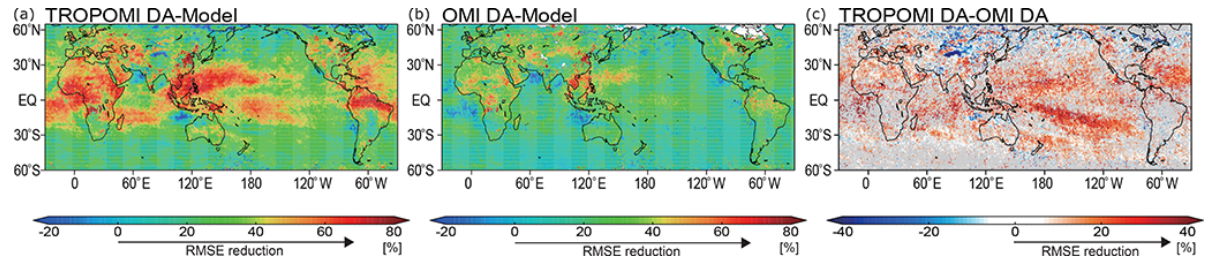
Figure 2. Root-mean-square error (RMSE) reduction for tropospheric NO 2 concentration fields against assimilated observations by data assimilation (DA) (%) obtained from Tropospheric Monitoring Instrument (TROPOMI) DA (a) and Ozone Monitoring Instrument (OMI) DA (b) , as well as the differences between them (c) . For the right panel, grids with a gray color indicate differences between RMSE reductions by TROPOMI DA and OMI DA that are statistically insignificant at the 95% confidence level using the Mann–Whitney U test. The values are mapped onto 0.56 ◦ resolution grids. Table 3. Root-mean-square error (RMSE) for tropospheric NO 2 concentration fields against assimilated observations after data assimilation (DA) (the control model simulation in brackets) and differences in RMSEs between DA and the control model simulation ( (cid:49) RMSE) over 60 ◦ S–60 ◦ N from 15 April–31 May. N denotes the ensemble size. RMSE and (cid:49) RMSE are expressed as × 10 15 molec.cm − 2 and percentage (%), respectively. Polluted regions are defined as the areas where the Tropospheric Monitoring Instrument (TROPOMI) tropospheric NO 2 column contains > 1 × 10 15 molec.cm − 2 . The ranges of RMSE and (cid:49) RMSE are the standard deviation of the time series. Assimilation runs 60 ◦ S–60 ◦ N Polluted Remote RMSE (cid:49)